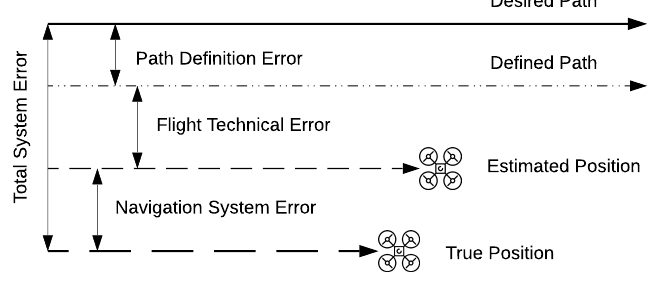
Figure 4. Total System Error of a UAV